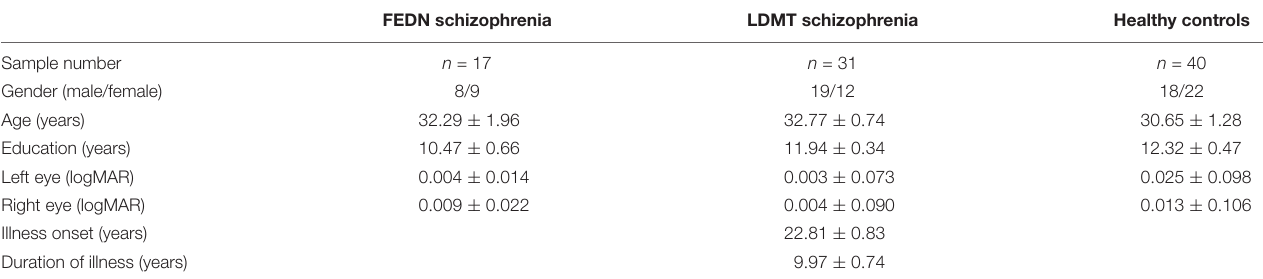
TABLE 1 | Demographic and clinical characteristics of FEDN, LDMT schizophrenia and healthy